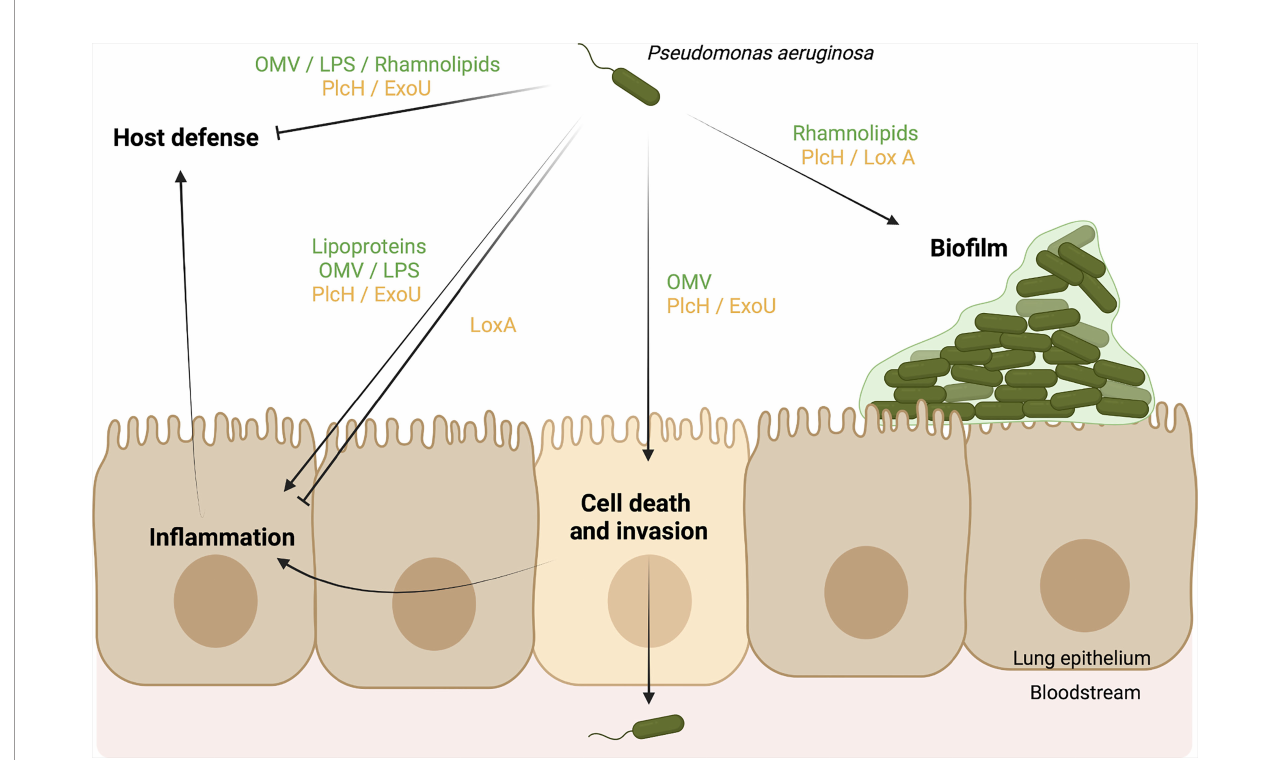
FIGURE 2 | Scheme model of Pseudomonas aeruginosa virulence factors using a lipid-based mechanisms to cause respiratory infections. Bacterial lipids (green) and bacterial enzymes (yellow) targeting host lipids promote ( ! ) or inhibit ( ˧ ) different biological functions during respiratory infections. They can (1) facilitate the bio fi lm formation of P. aeruginosa , (2) promote the death of host cells and the invasion of tissues, leading to the spread of P. aeruginosa in the bloodstream, (3) interfere with the in fl ammatory response, and (3) block the host defense (e.g. neutrophils, macrophages). As a result, P. aeruginosa can bene fi t from lipid mechanisms to persist in its host. Created in